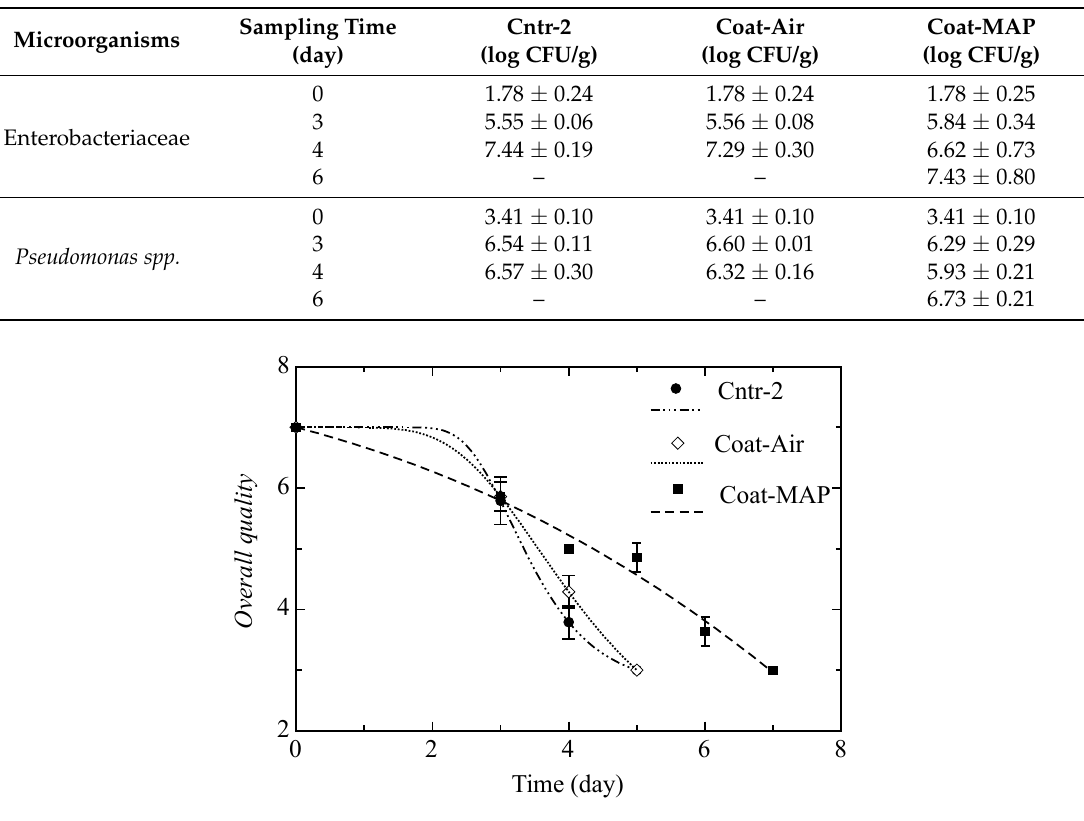
Figure 3. Overall Quality for Step 2 burrata samples (• Cntr ‐ 2: burrata packaged in air; ◊ Coat ‐ Air: burrata coated with aginic acid and packaged in air; ▪ Coat ‐ MAP: burrata coated with aginic acid and packaged under 65:35 CO 2 :N 2 ). The curves are the best fit of the re ‐ parametrized Gompertz equation to the experimental data.